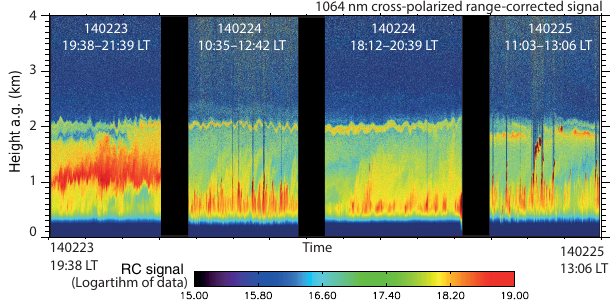
Figure 3. Three days of lidar observations (23–25 February 2014) of layers with dried marine particles in the marine aerosol layer (MAL). On 23 February (left panel), a vertically extended layer of dried sea salt particles (red area) occurred on top of the con- vective boundary layer. A continuously 100–200m thick layer with dried marine particles (yellow layer at MAL top) was present over the whole day on 24 February 2014; this layer was still present on 25 February. The convectively active MBL reaches about 1km on all 3 days and permanently pushed marine aerosol upward. The shown range-corrected 1064nm backscatter signal (cross-polarized channel, 10s temporal, 7.5m vertical resolution) is most sensitive to enhanced light depolarization produced by dry marine aerosol. LT: local time.